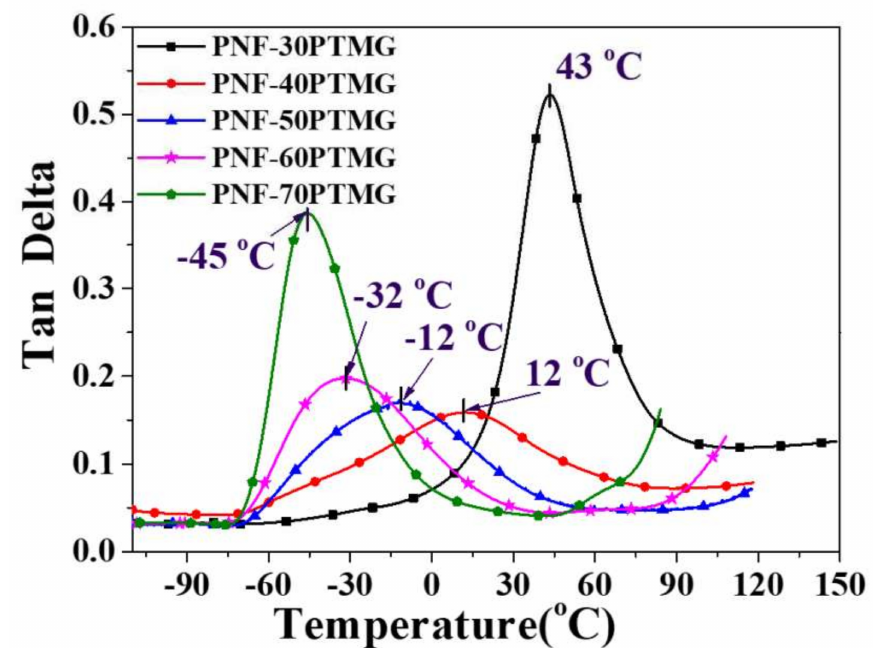
Figure 18. Evolution of α relaxation with the introduction of “soft” poly(tetramethylene glycol) (PTMG) segments in poly(neopentyl glycol 2,5-furandicarboxylate) (PNF)